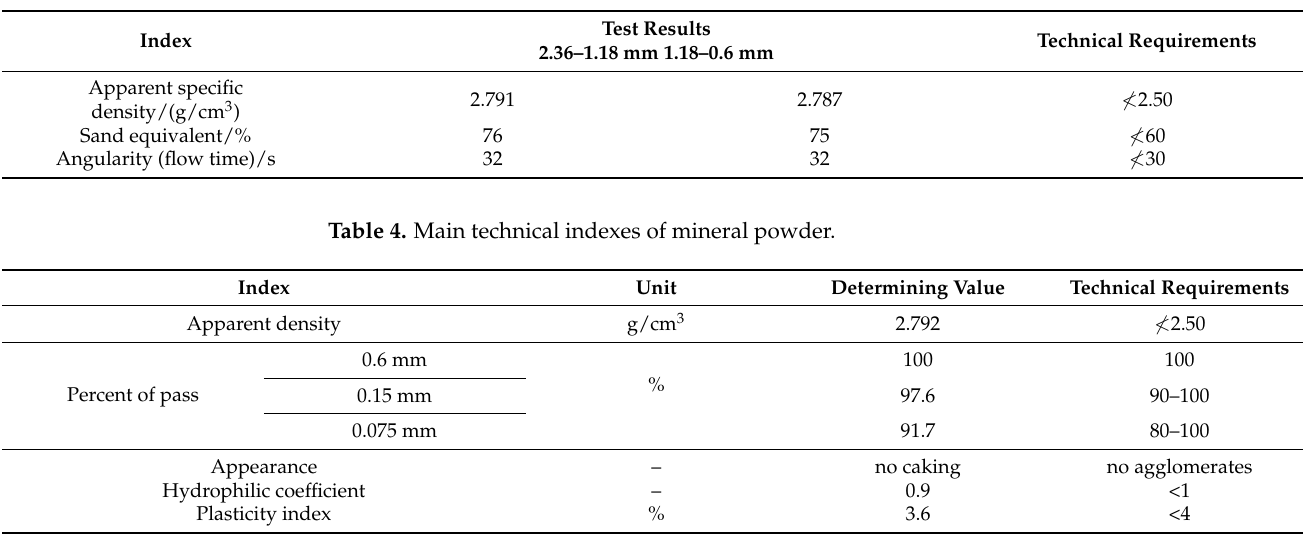
Table 3. Main technical indexes of 2.36 mm~1.18 mm gravel.